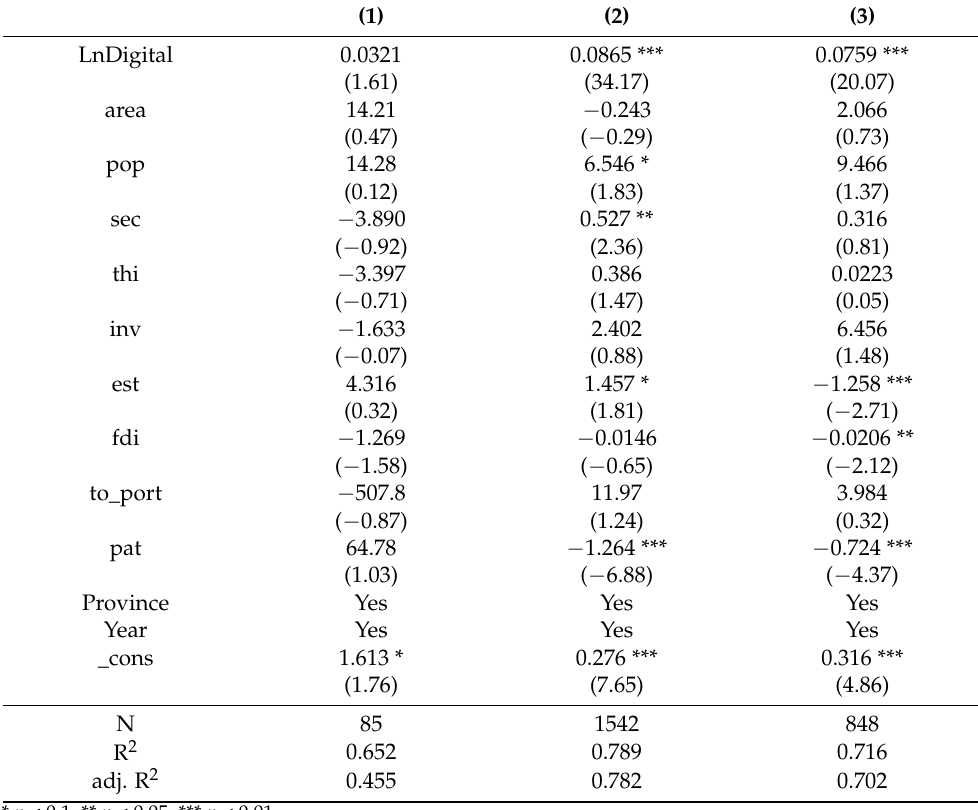
Table 9. Influence of Degree of Digital Economy on Green Productivity: Heterogeneity in Terms of Urban